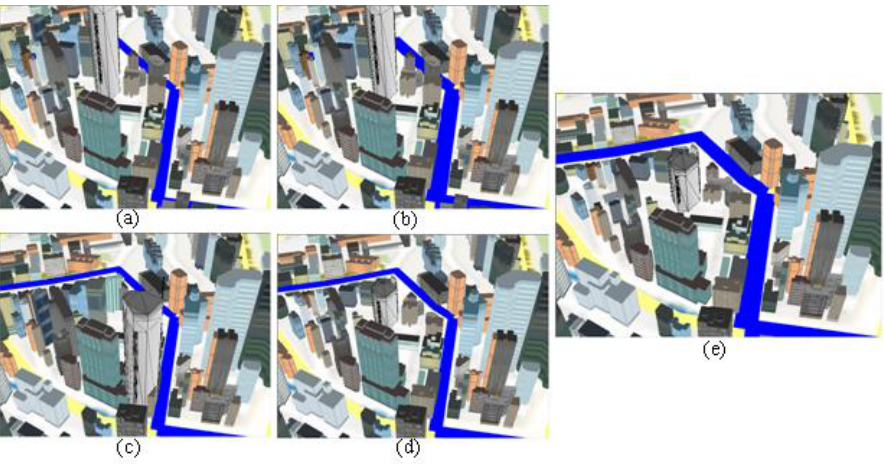
Figure 2. Disocclusion of the relevant route (blue): ( a ) the original view; ( b ) road broadening; and ( c ) building displacement. Some buildings are moved too far. ( d ) The buildings are zoomed out. ( e ) Combined road widening, building displacement, and building scaling to remove occlusions. Compared to ( b – d ), the view in ( e ) not only eliminates occlusions but also retains a resemblance to (a).